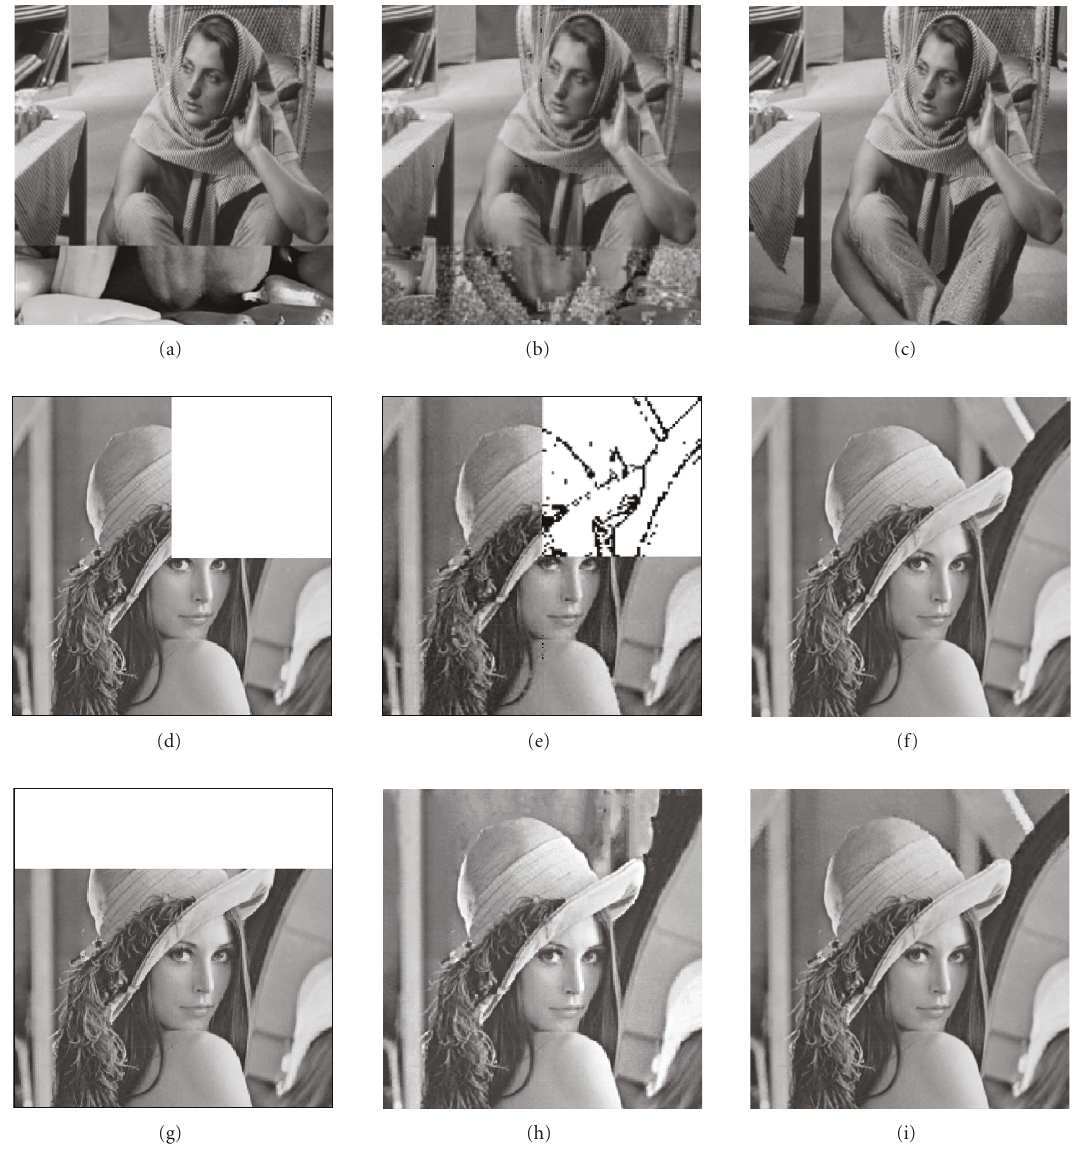
Figure 8: A comparison of the recovered images of [10, 13, 14] and the proposed method, with tampering or cropping in the same region: (a) 25% of a 512 × 512 watermarked image Barbara (W) is replaced; (b) the recovered image of [10]; (c) the recovered image of the proposed method; (d) 25% of a 512 × 512 watermarked image Lena (W) is cropped; (e) the recovered image of [13]; (f) the recovered image of the proposed method; (g) 25% of a 256 × 256 watermarked image Lena (W) is cropped; (h) the recovered image of [14]; (i) the recovered image of the proposed